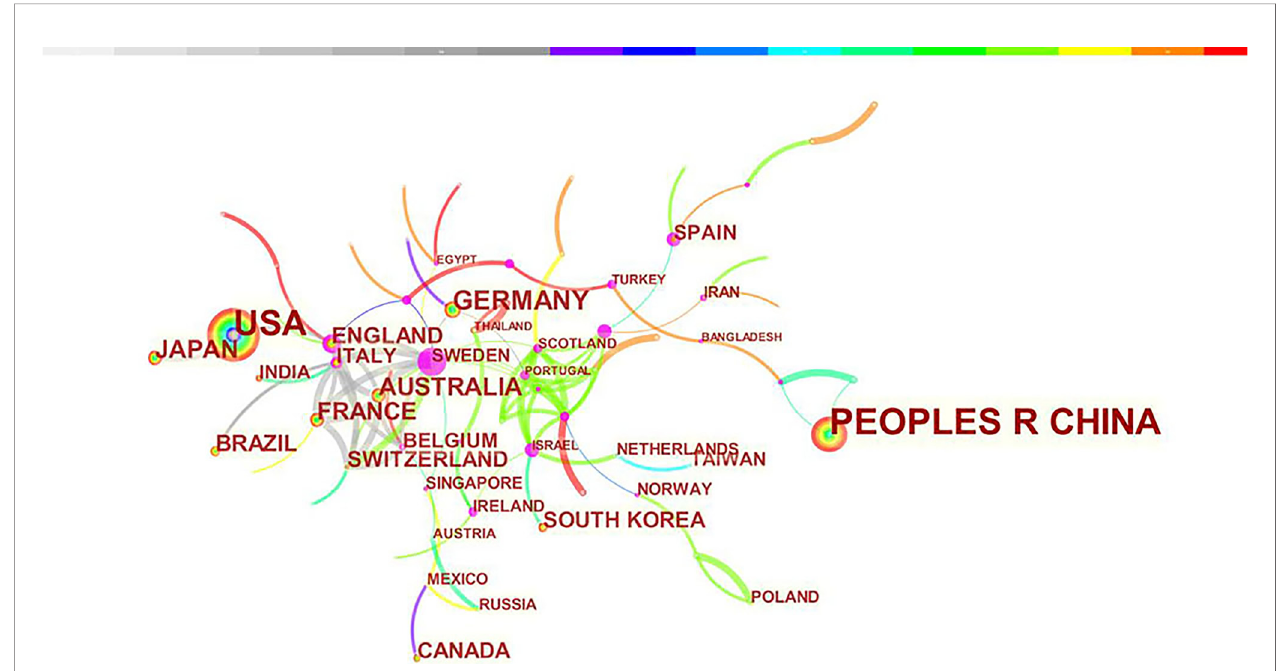
FIGURE 3 | Distribution of publications from different